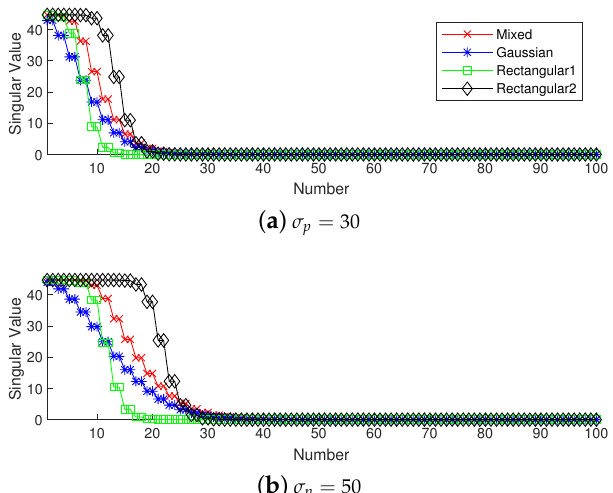
Figure 5. Singular value spectrum of different weighted sensing matrices with weight widths given by ( a ) σ p = 30; ( b ) σ p =